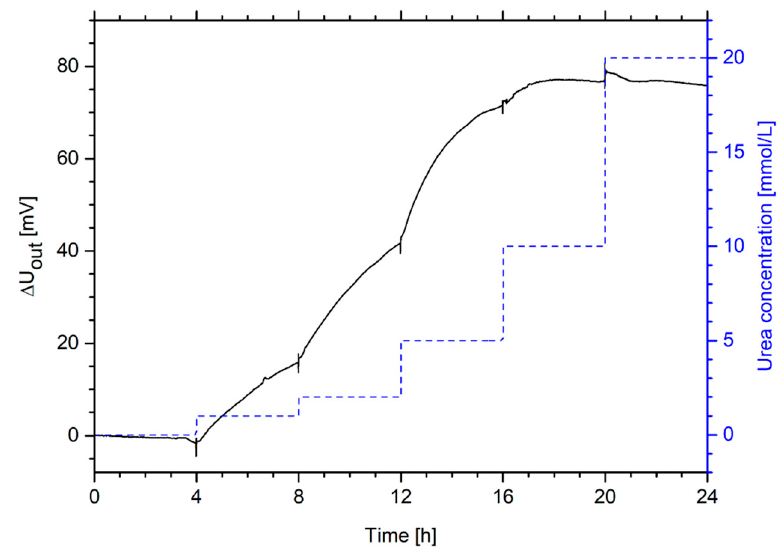
Figure 9. Sensitivity range of a hydrogel-based piezoresistive urea biosensor—Measurement of the output voltage Δ U out for changes of the urea concentration in a range from 0 mmol/L to 20 mmol/L urea.